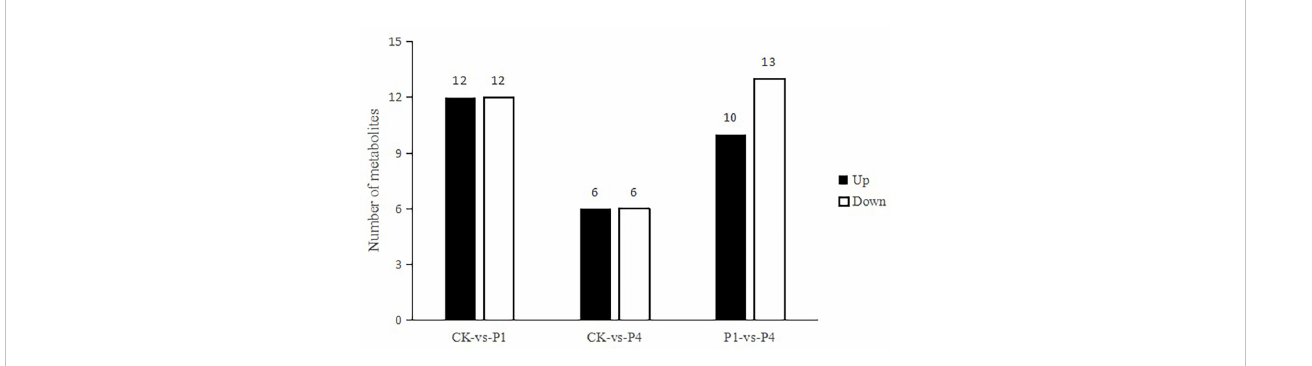
FIGURE 5 The total number of differential metabolites with differential levels, upregulated and downregulated, under different P treatments.